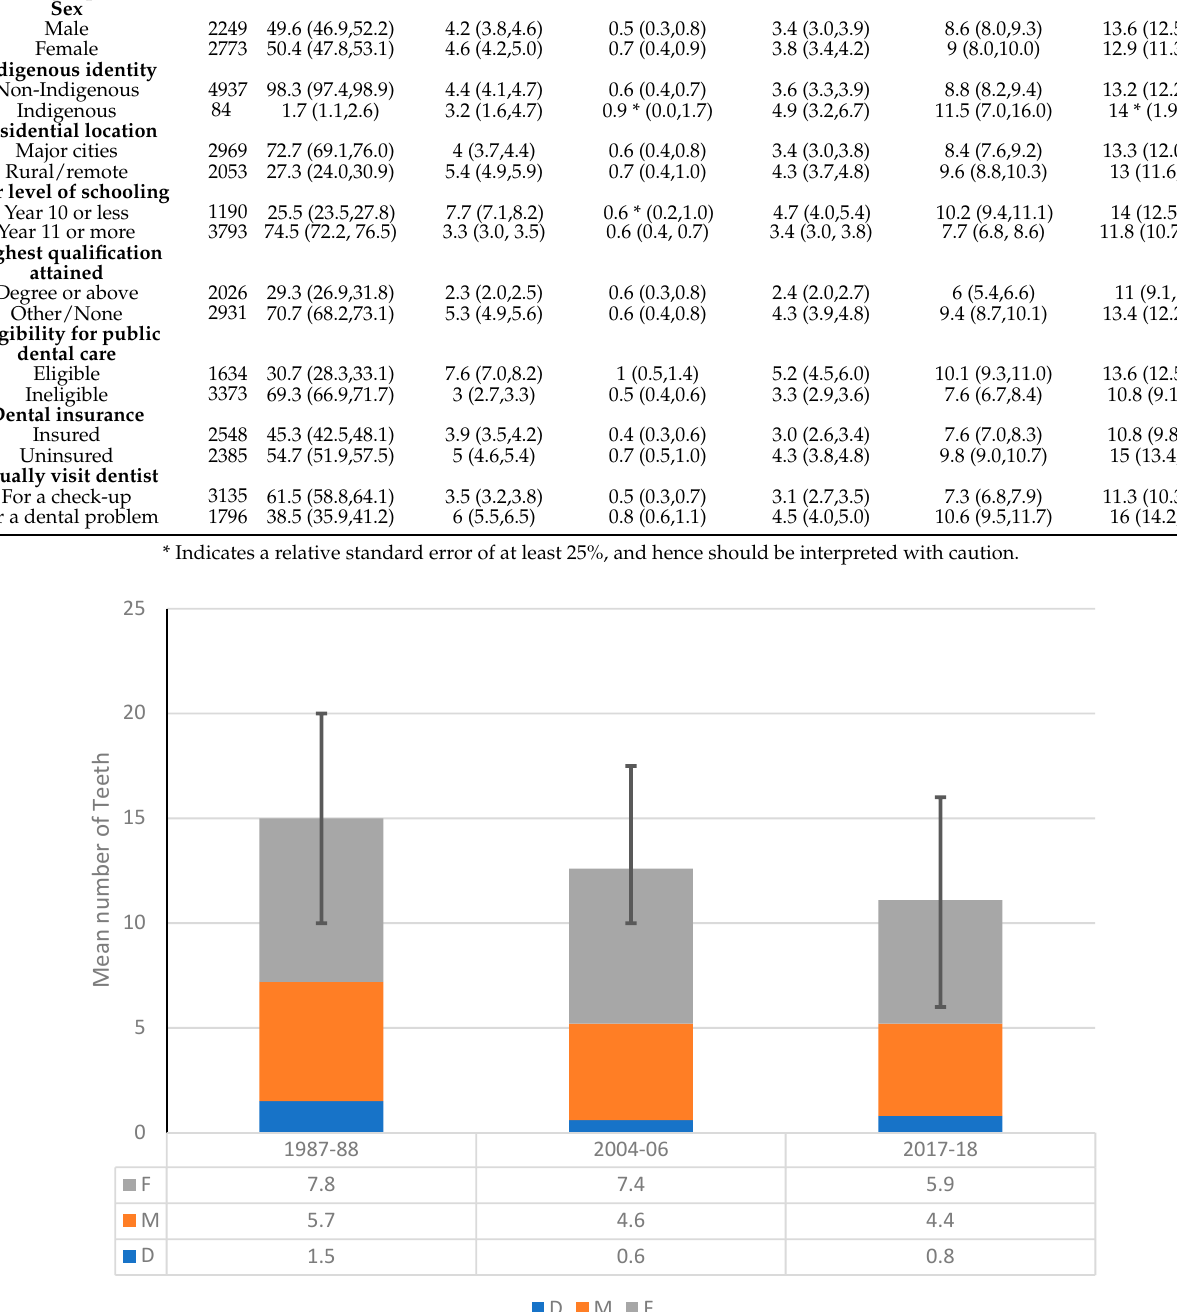
Figure 1. Trends in dental decay experience among dentate Australians aged 15 years and over, 1987–88, 2004–06 and 2017–18.